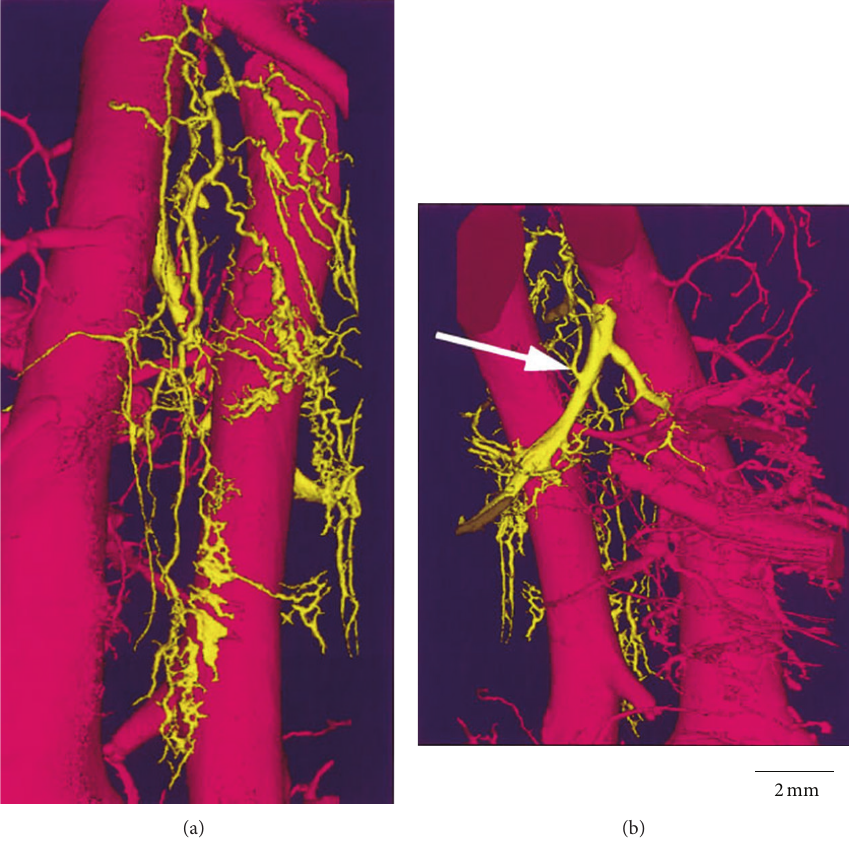
Figure 2: Volume-rendered micro-CT image of a VVV (yellow). (a) In addition to the left anterior descending coronary artery (right, pink) and the concomitant vein (left, pink), the figure shows the complex structure of the VVV, which finally drains into a branch (white arrow) of the concomitant vein ((b), displayed at 180 ∘ to (a)). The VVV develops inside the coronary artery wall and forms this complex tree-like structure (reprint with permission from